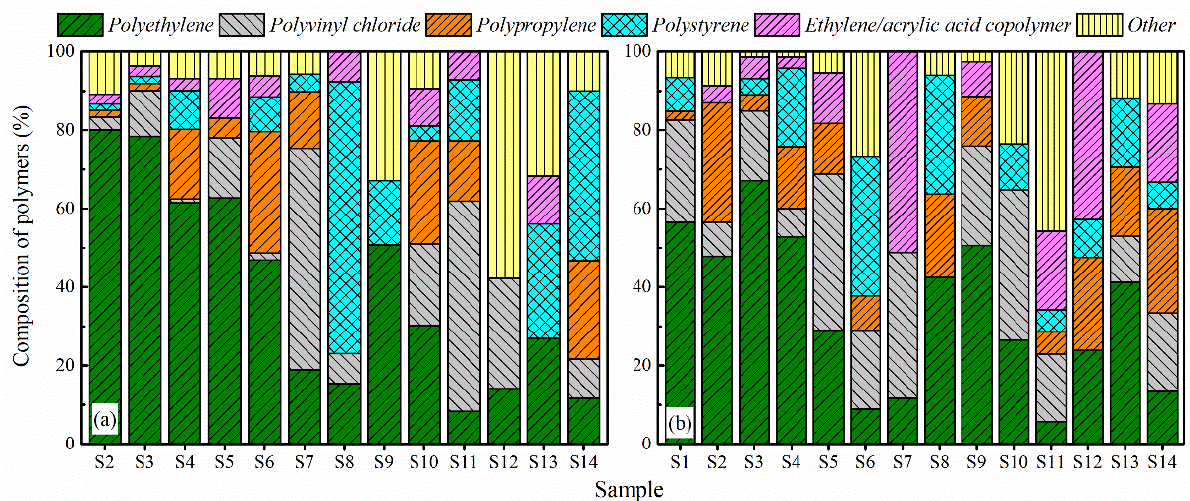
Figure 7. Composition of MPs collected in a coastal region of the PRE: ( a –Rain season, b –Dry season).